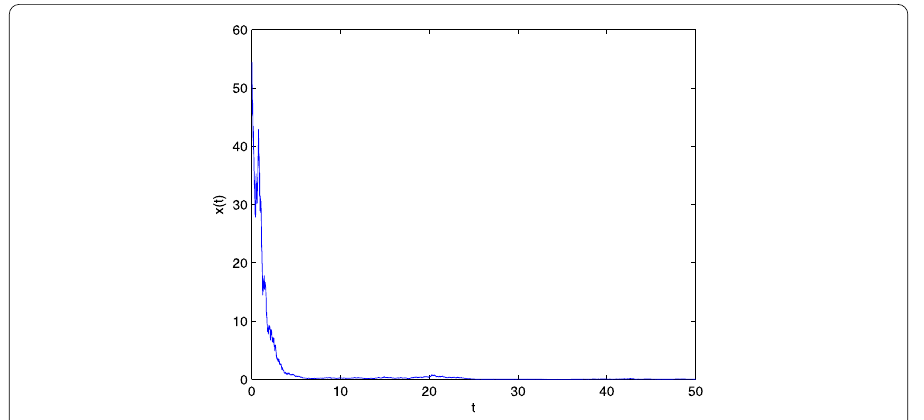
Figure 2 Pest population of model (2.2): The parameter values are fixed as follows: x 0 = 50, r = 0.3, α 1 = 0.6, K =